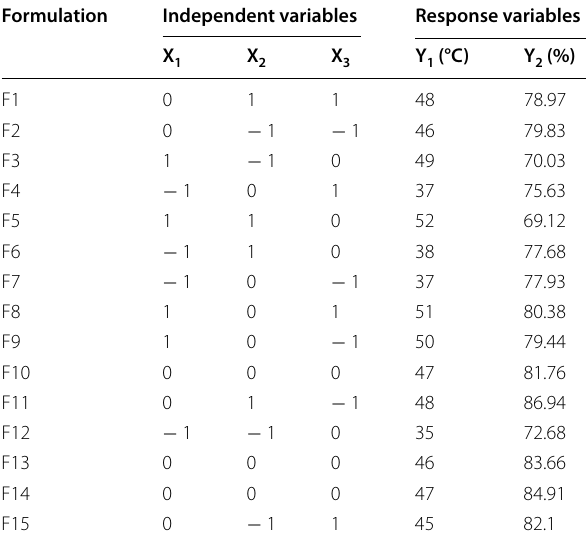
Table 3 Observed responses for softening point (Y percentage drug release after 12 h (Y the BBD